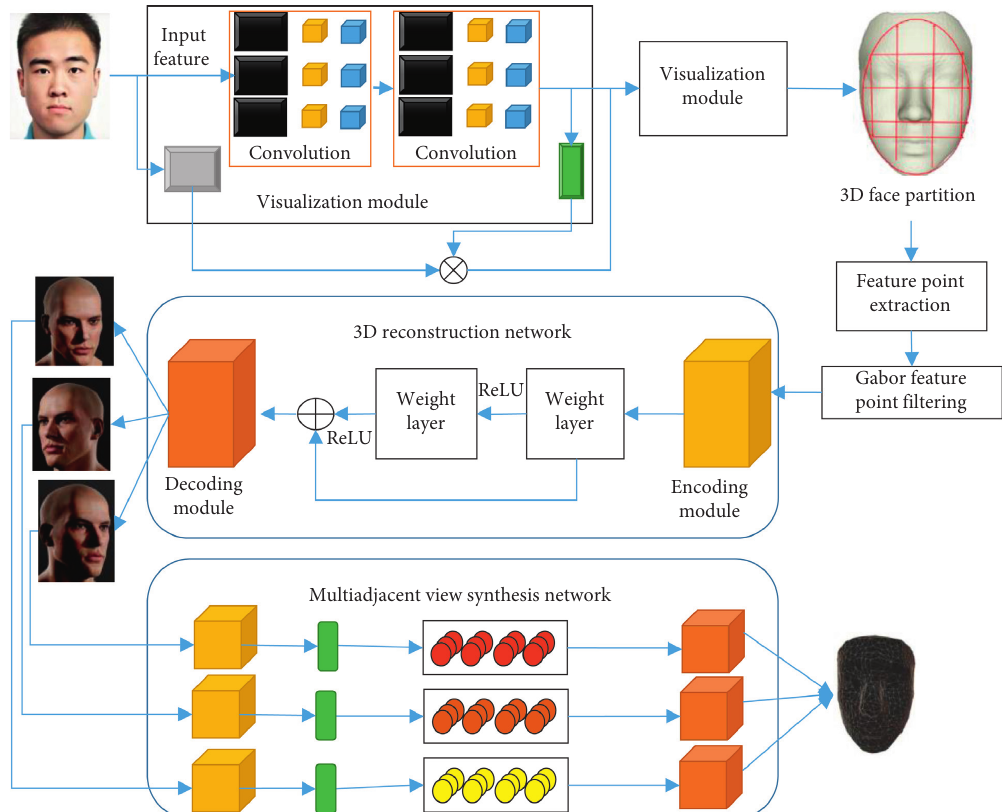
Figure 3: The implementation framework of the network constructed in this